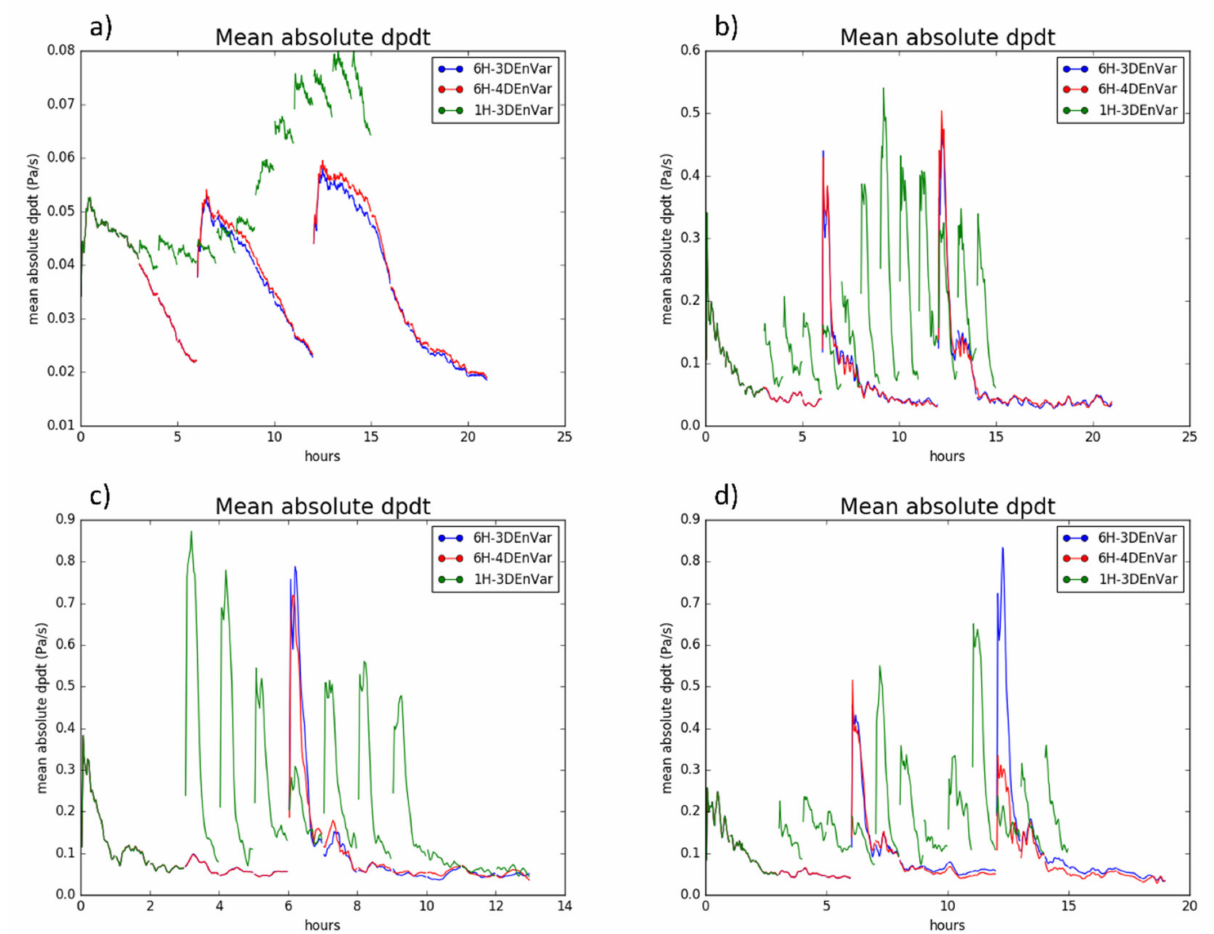
Figure 9. Mean absolute pressure tendency averaged over ( a ) the full outermost domain for E1 and E2, and ( b – d ) over the innermost domain during ( b ) E1 and E2, ( c ) E3, and ( d ) E4 and